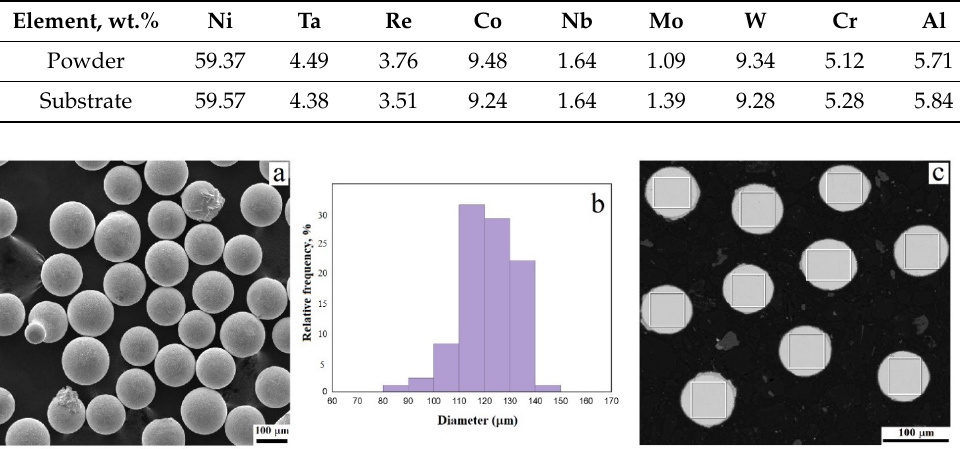
Figure 2. The feeding powder: ( a ) morphology of the feed powder; ( b ) particle size distribution histogram; ( c ) cross-sectional SEM micrographs of